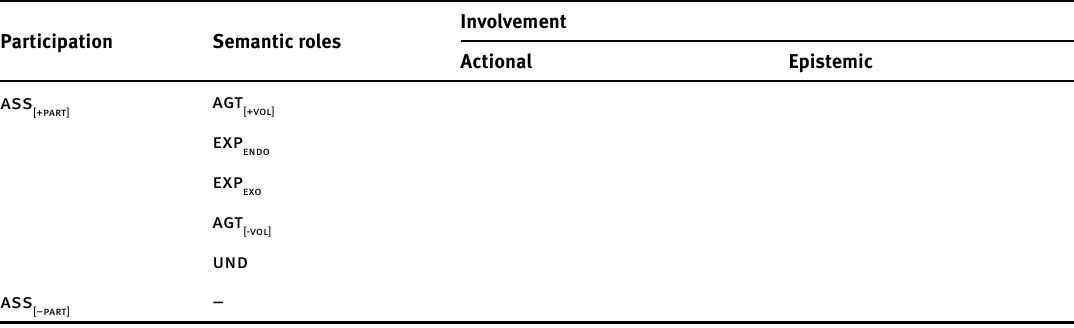
Figure 3. The assertor’s (non-)participation, semantic roles, and involvement